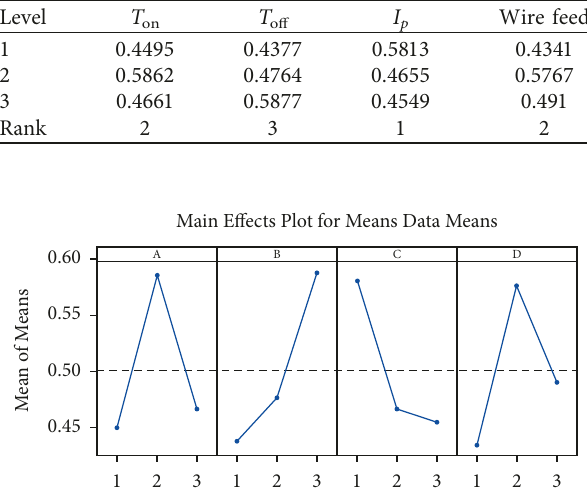
Table 22: Response table for zinc-coated brass wire.